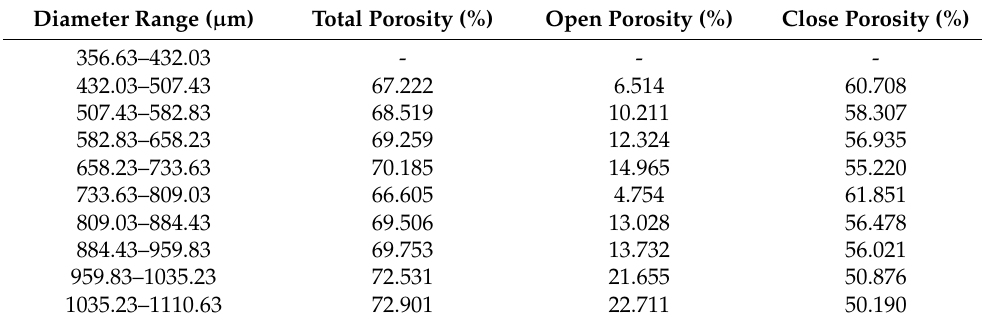
Table 3. Percentage of total, open, and closed porosity for the different diameter